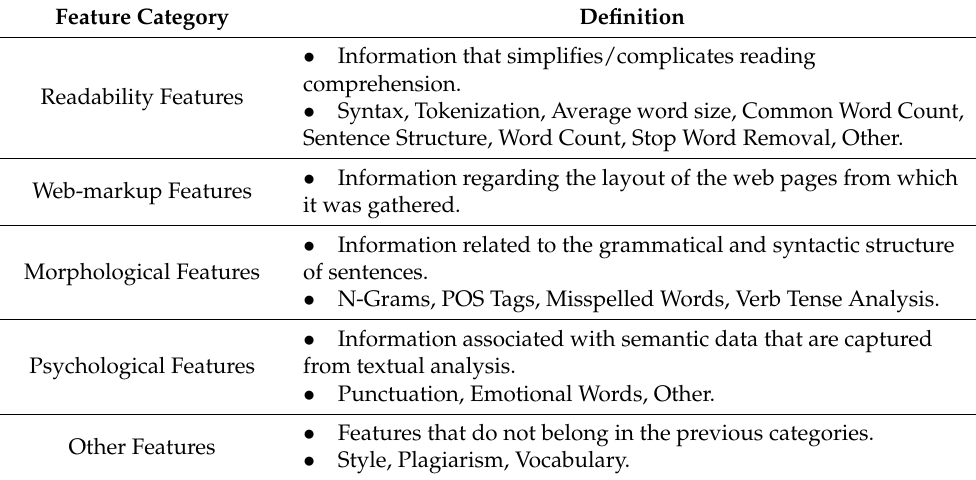
Table 3. Categories of Data Pre-processing